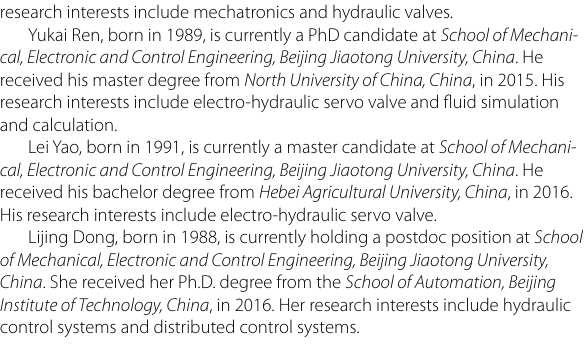
Figure 26 Comparison of the pressure difference